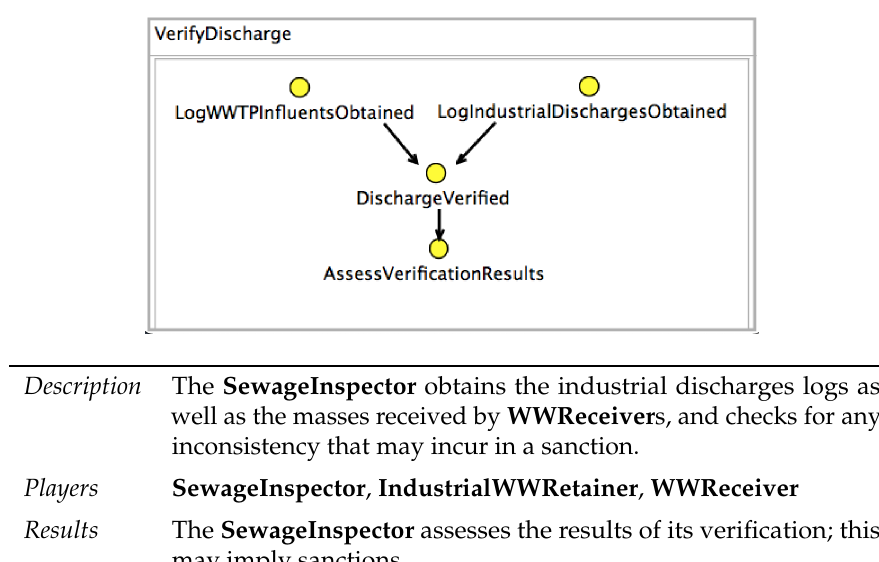
Figure A5. Landmark patterns show how logged information (influents previously received by WWTP) is double-checked against agreed industrial